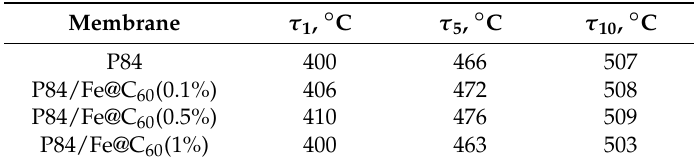
Table 2. Thermal stability indices of membranes.